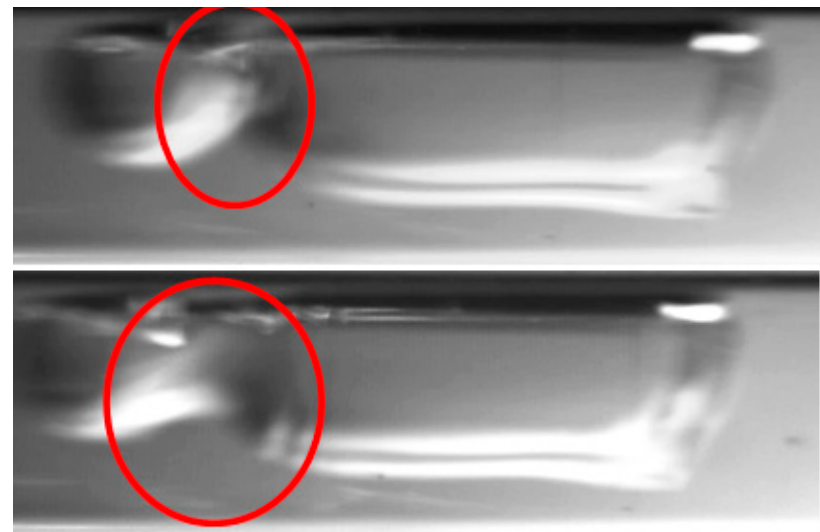
Figure 16. An example of the occurrence of vapor bubbles coalescing during the two ‐ phase flow of Novec649 refrigerant in a minichannel with an internal diameter of d h = 2.0 mm ( G = 2089 kg/m 2 s; x = 0.011; ϕ = 0.54; t s = 52 °C).